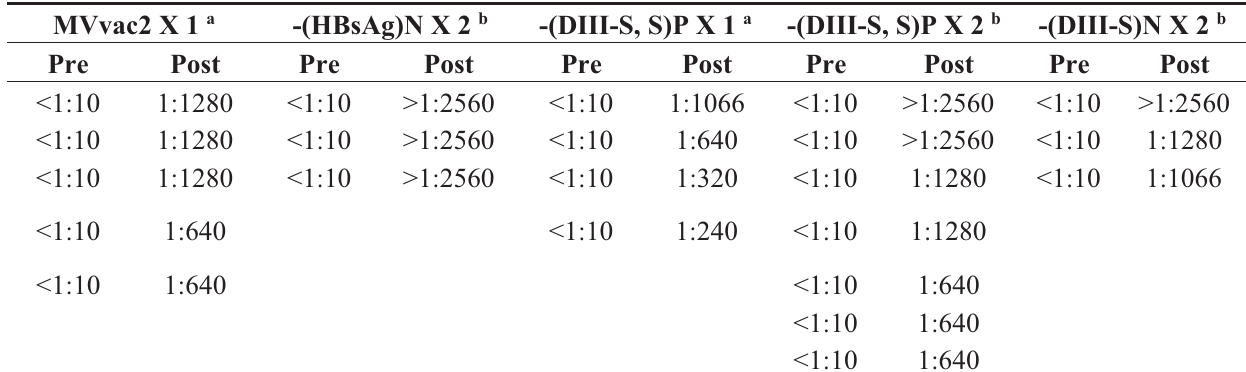
Table 1. Anti-Measles immunogenicity (PRNT 90 titer).